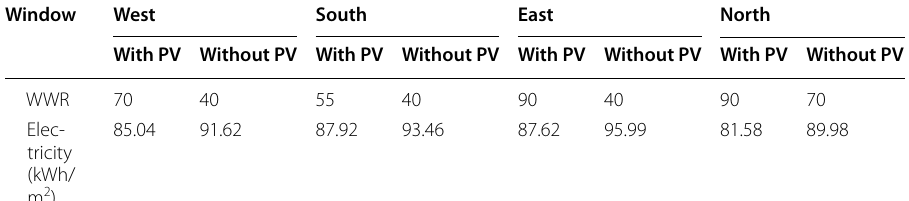
Table 9 Optimal WWR at minimum net annual electricity consumption for W1 window Window West South East North With PV Without PV With PV Without PV With PV Without PV With PV Without PV